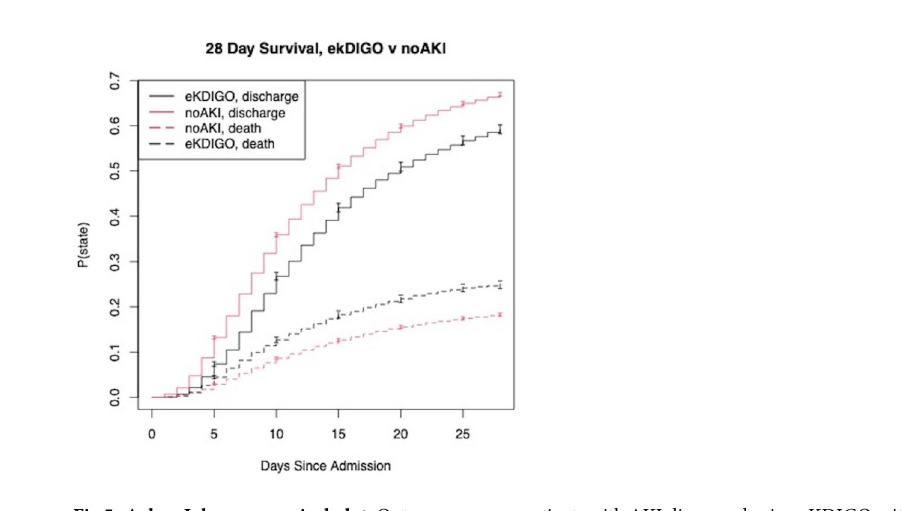
Fig 5. Aalen–Johansen survival plot. Outcomes among patients with AKI diagnosed using eKDIGO criteria and no AKI. Confidence bars are used to illustrate a 95% confidence interval. AKI, acute kidney injury; eKDIGO, extended